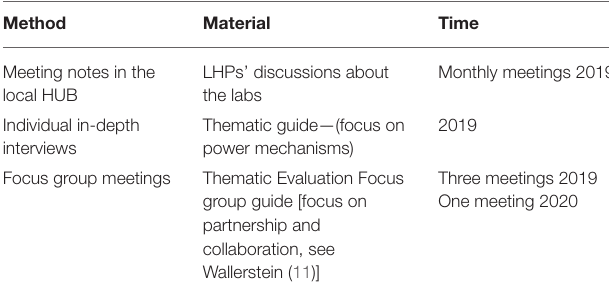
TABLE 3 | Overview of documentation analysed in this